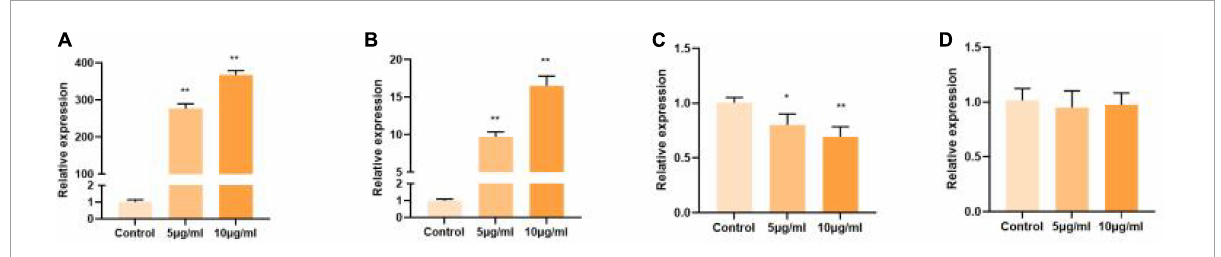
FIGURE2 Comparison of polysaccharide fractions from different species of Polygonati Rhizoma. Influence of purified polysaccharides on cell gene expression of SOD1 in vitro . (A) PSP-NP; (B) PSP-AP; (C) PCP-AP; (D) PCP-NP. * Indicated significant difference compared with a control group, P < 0.05; ** indicated